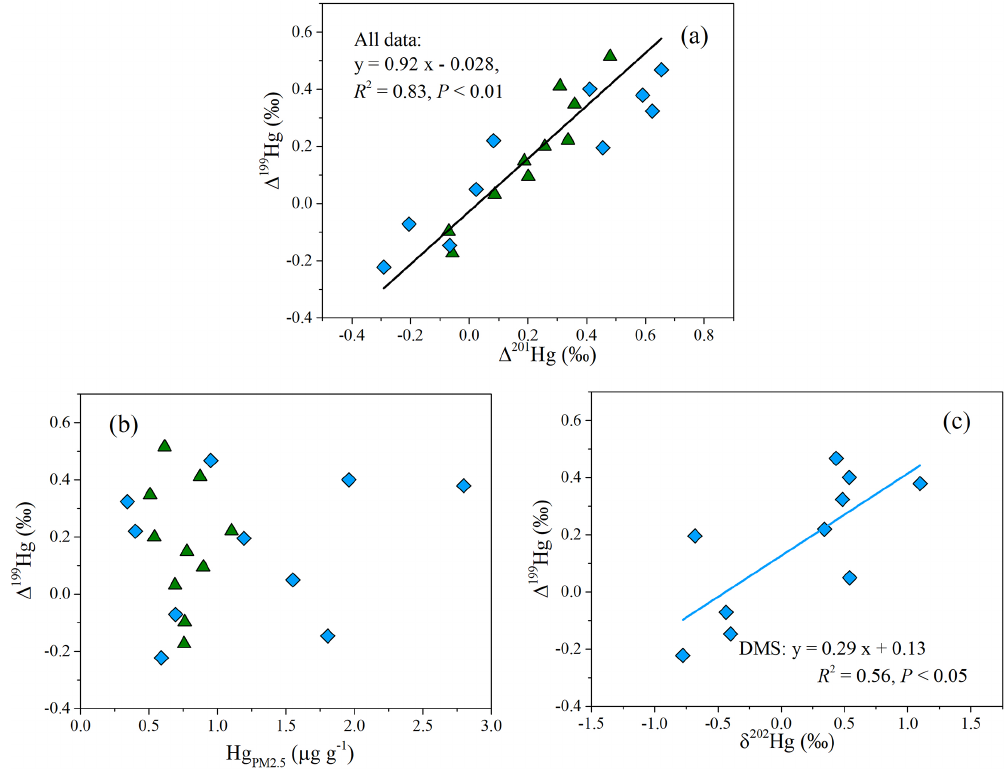
content, and (c) (cid:49) 199 Hg and δ 202 Hg at 2 . 5